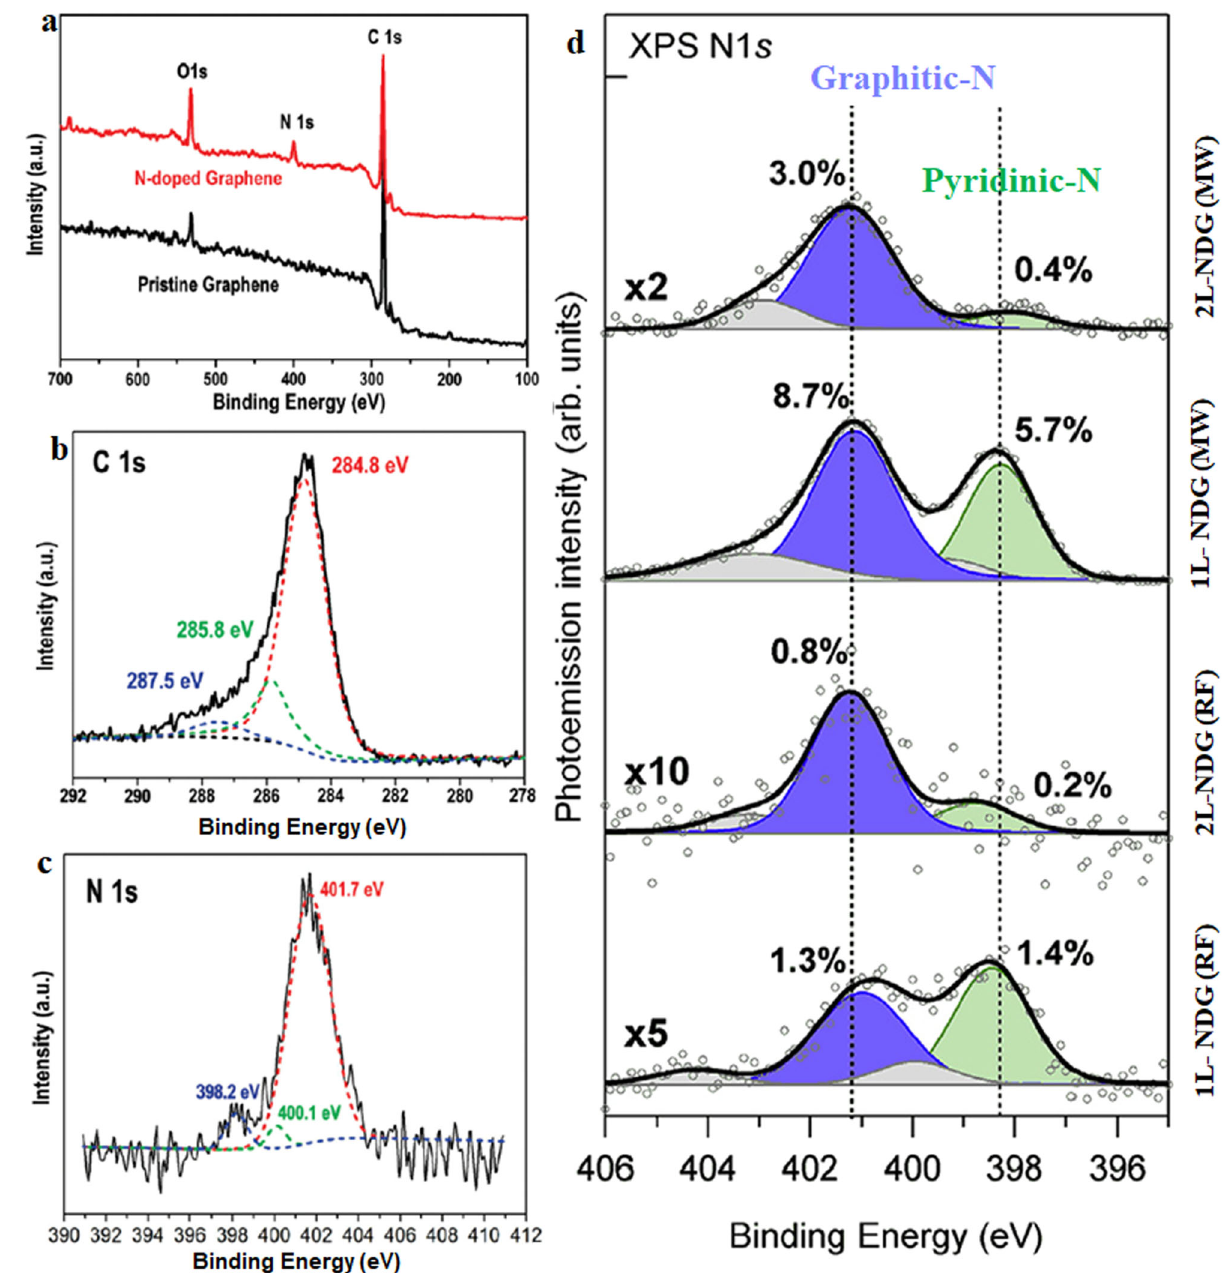
Fig. 4 X-ray photoelectron spectroscopy results. a Survey spectra and b , c High-resolution core-level C1s and N1s spectra of NDG obtained via thermal CVD (reprodcuced from 56 with permission from the American Chemical Society), d N1s spectra of NDG samples treated with microwave (MW) and radio-frequency (RF) plasmas. The numbers state the N at.% deduced from spectral analyses of graphitic-N and pyridinic-N (reproduced from 79 with permission from